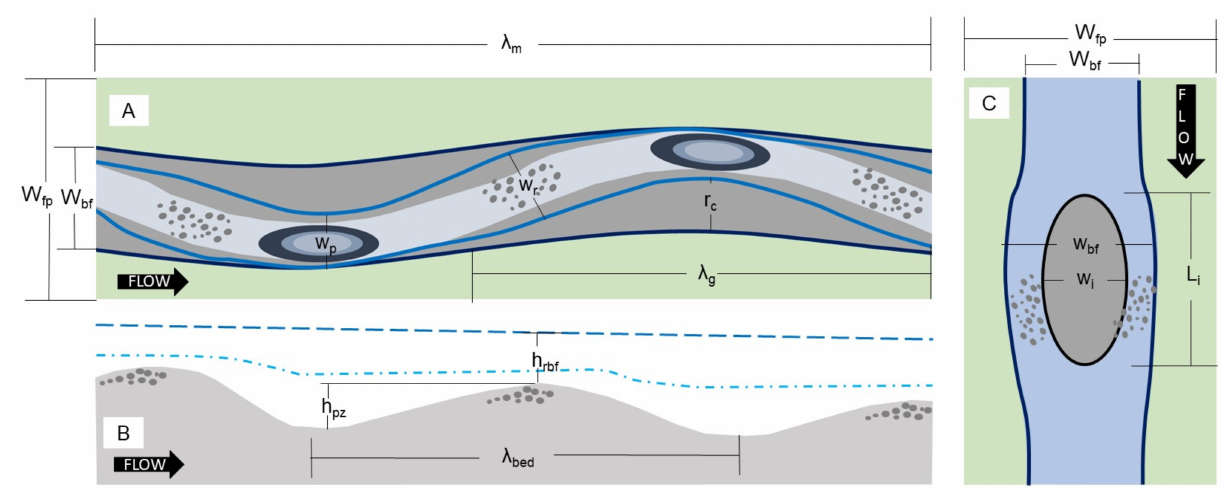
Figure 5. Definition sketches for archetypes of alternate bar geometry ( A ) and corresponding bed profile with pool–riffle variation ( B ) and island geometry ( C ) for variables discussed in the text. While natural rivers have considerable diversity depending on local and site-specific conditions, these schematics can serve as a guide for developing the relative size and orientation of mesohabitat units for these planform